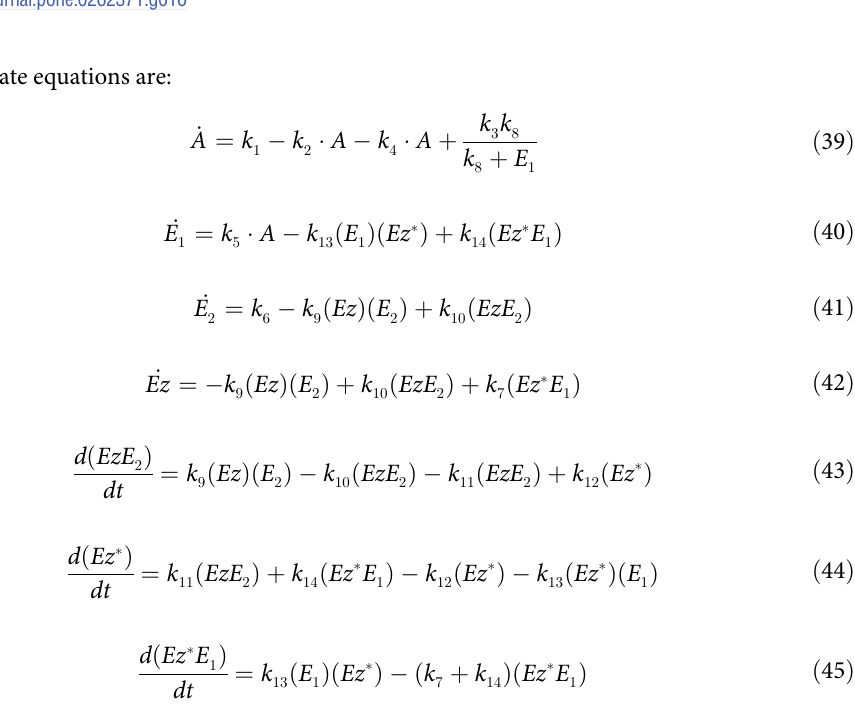
Fig 17 shows the switching behavior from dual-E control, gray dots on blue lines) to single- E control (horizontal gray dots) with changing k and k . The red lines indicate the steady state of A when single-E control mode works under 13